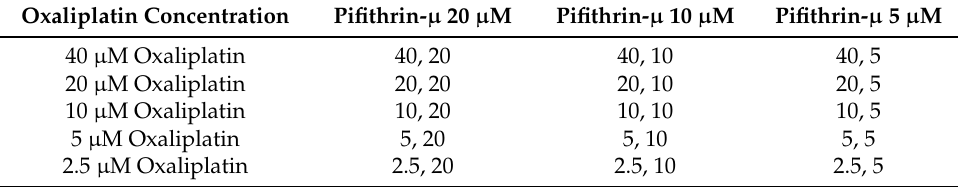
Table 3. Combined drug concentrations investigated against HT29 colorectal cancer